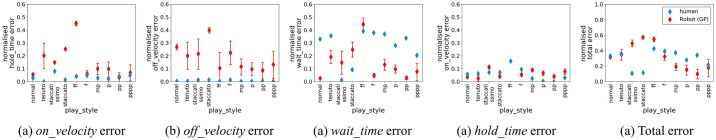
Comparison of the playing score of the robot optimized to play the 10 different playing styles after 3125 learning epochs, a human player playing the same, and the computer generated outputs.